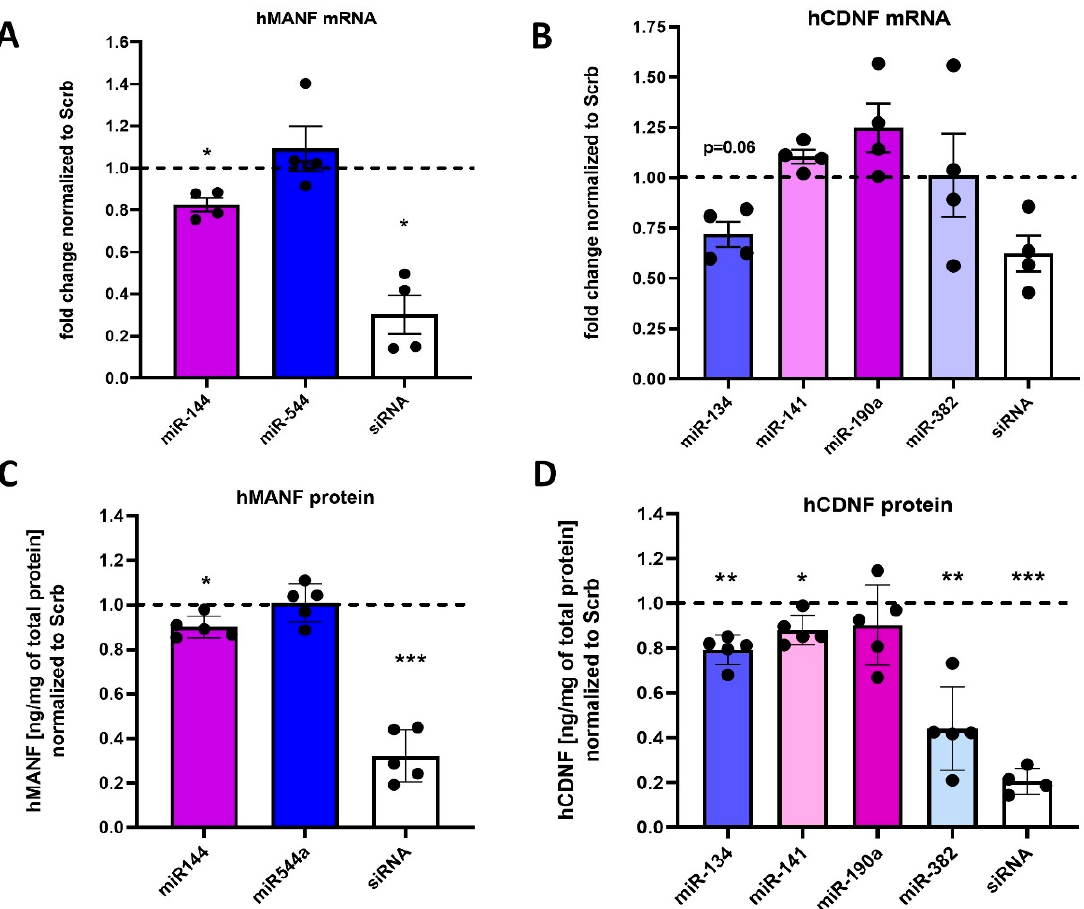
Figure 4. Regulation of endogenous hMANF ( A , C ) and hCDNF ( B , D ) expression by miRNAs in HEK293T cells. Results of mRNA or protein levels are represented relative to negative control (Scrb). Each dot represents mean value from one inde- pendent experimental plate with 2–4 wells per treatment group. *— p -value < 0.05, **— p -value < 0.01, ***— p -value < 0.001.